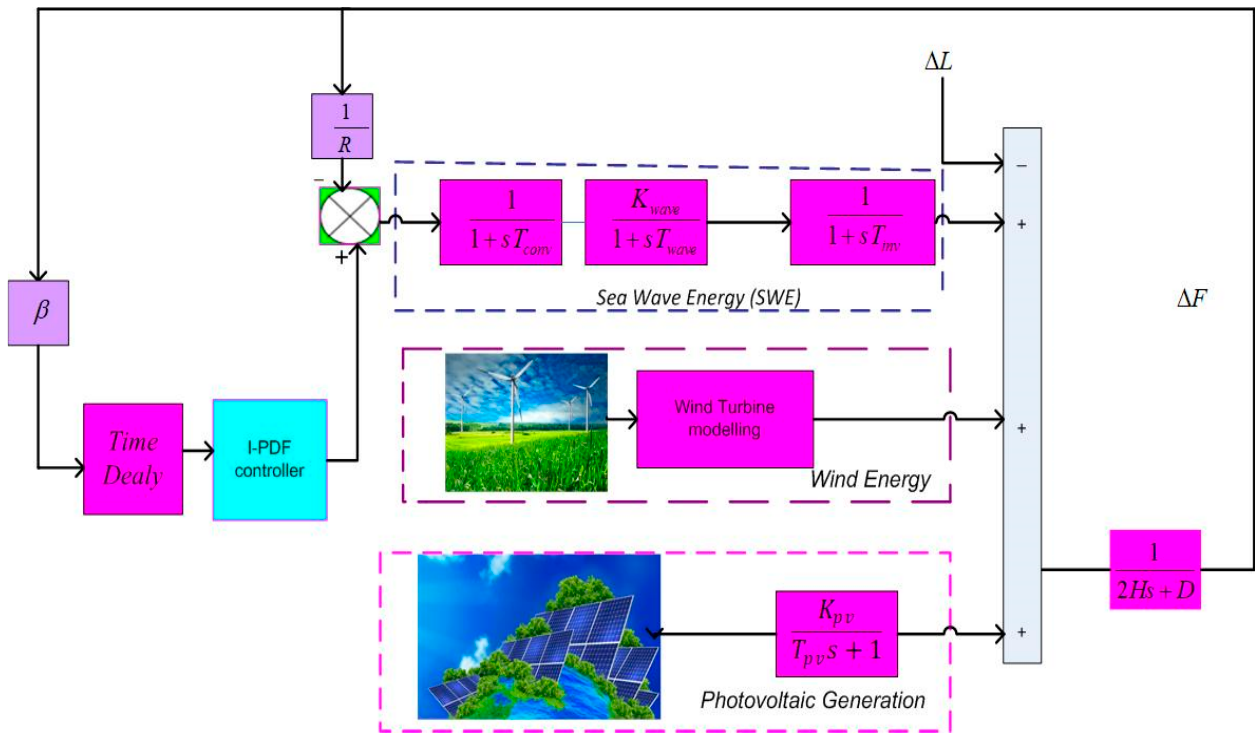
Figure 1. Modelling of marine microgrid system.